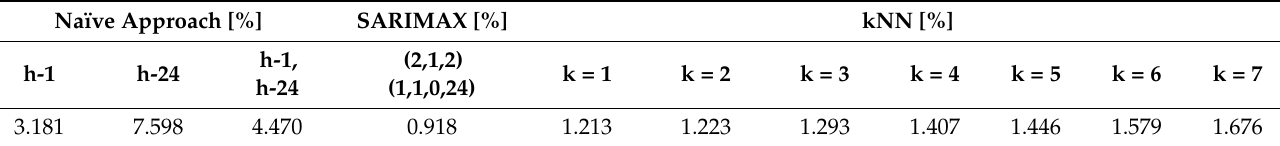
Table 3. MAPE values for naïve approach, SARIMAX model, and kNN algorithm for the second verification case. Naïve Approach [%]